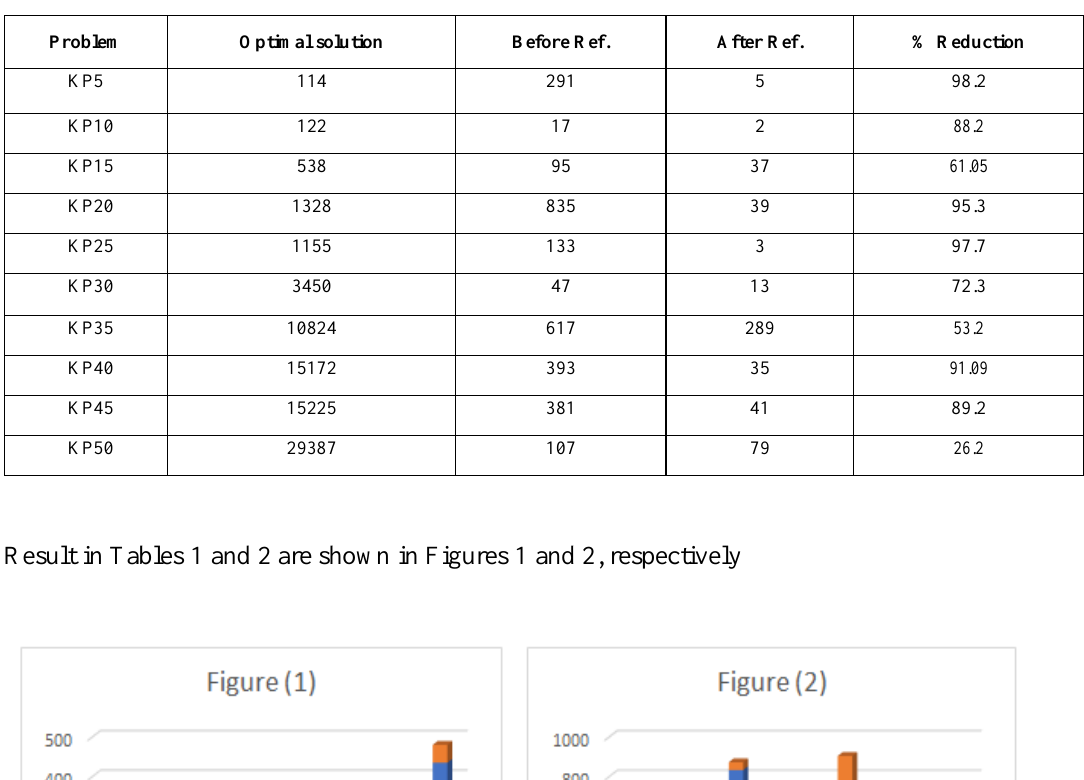
Table 2. Comparison with respect to the number of sub-problems before and after the reformulation using the branch and bound on Tora